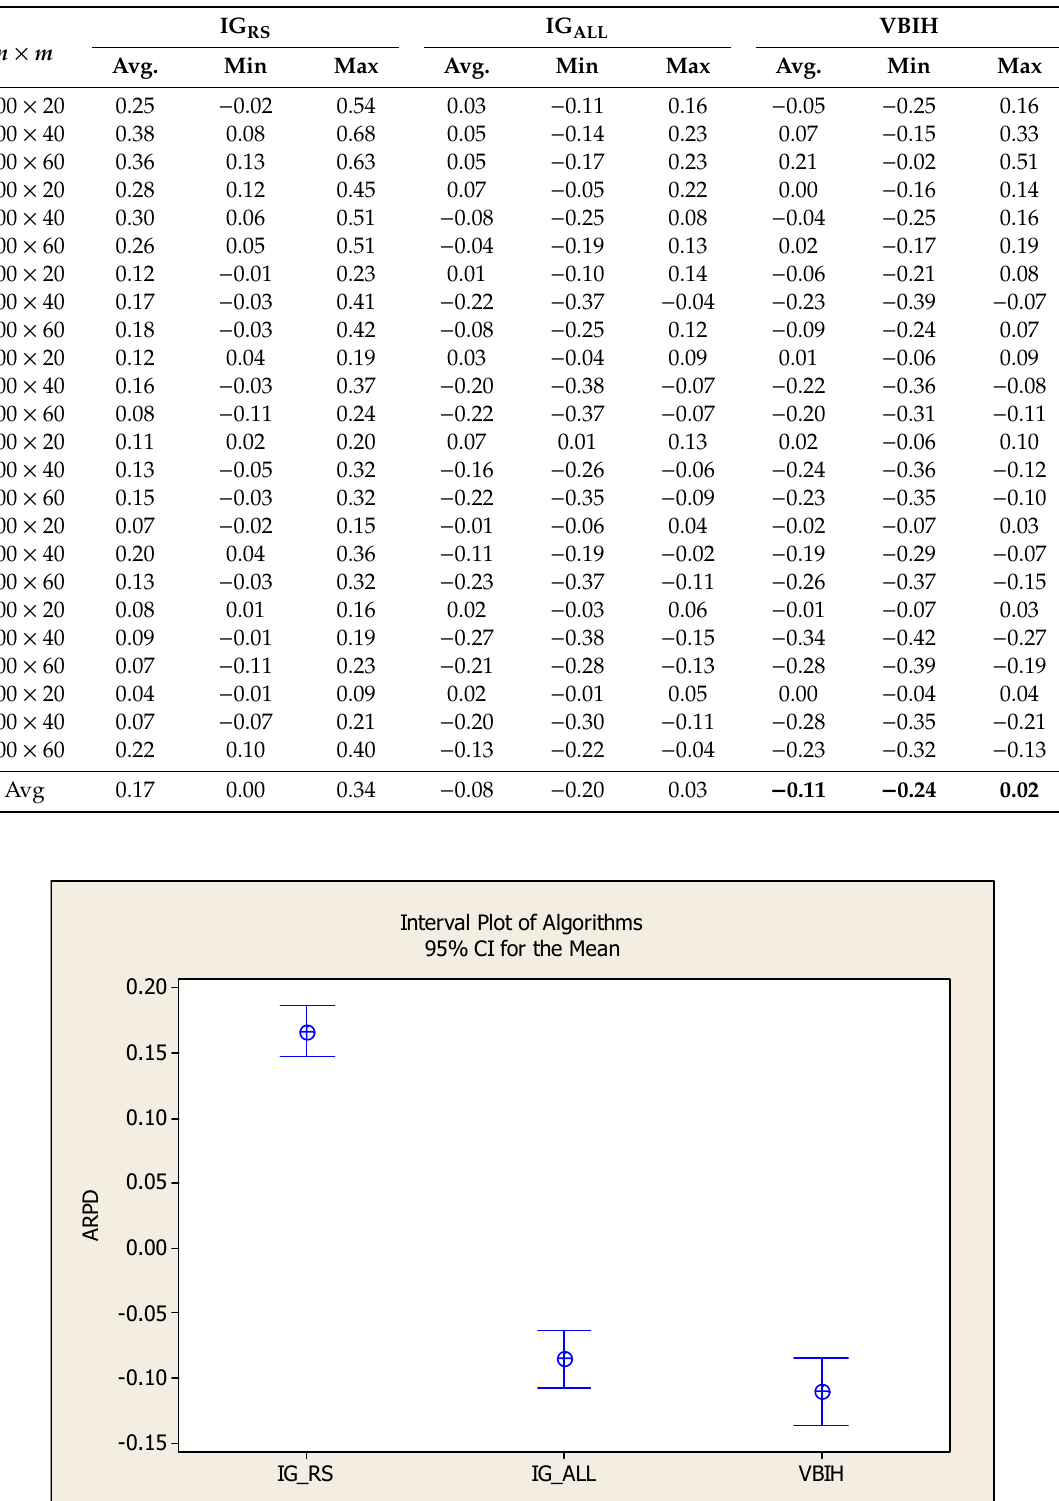
Table 7. Computational results of algorithms with T max = 30 × n × m milliseconds (The bolds show better results).